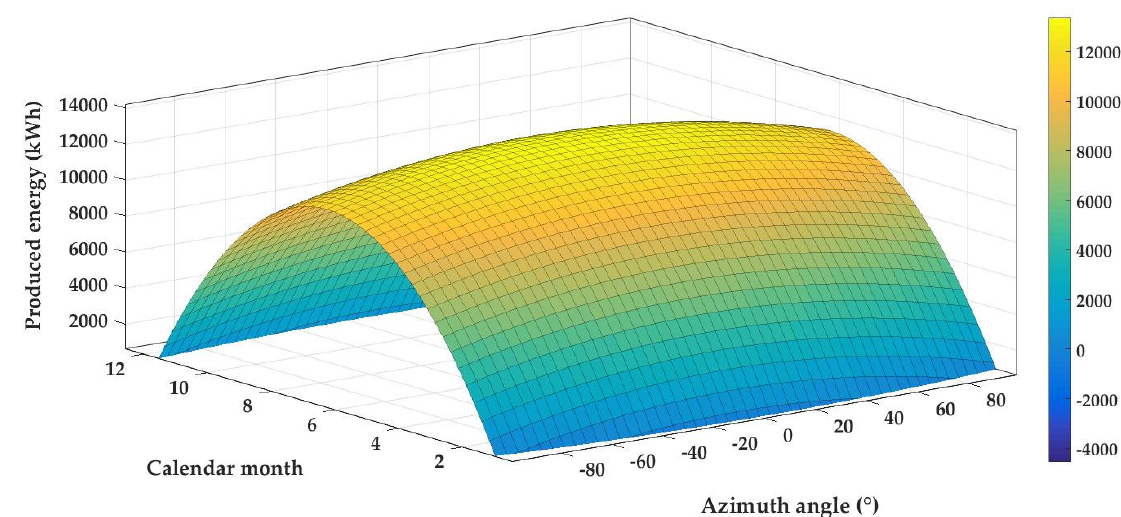
Figure 15. Three-dimensional dependence after polynomial approximation—the influence of azimuth angle on the electric energy production of PV system for calendar months.